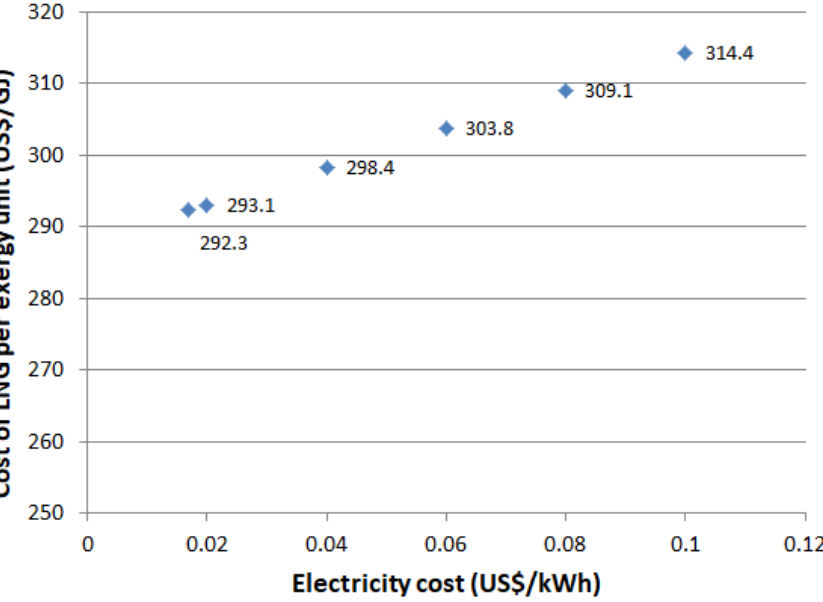
Figure 2. Results of exergoeconomic analysis of natural gas liquefaction process. The effect of electricity cost on the specific cost of liquefied natural gas is shown in Figure 3.